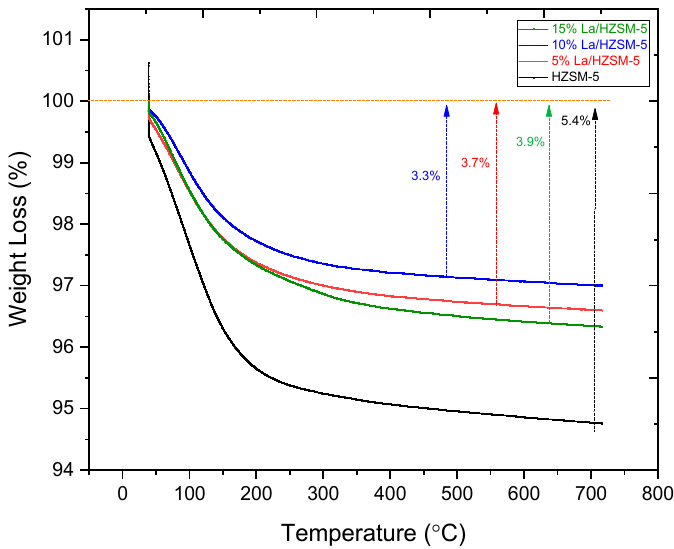
Figure 7. TGA of the fresh parent HZSM-5 and fresh lanthanum-modified HZSM-5 with different loading-weight percentages.